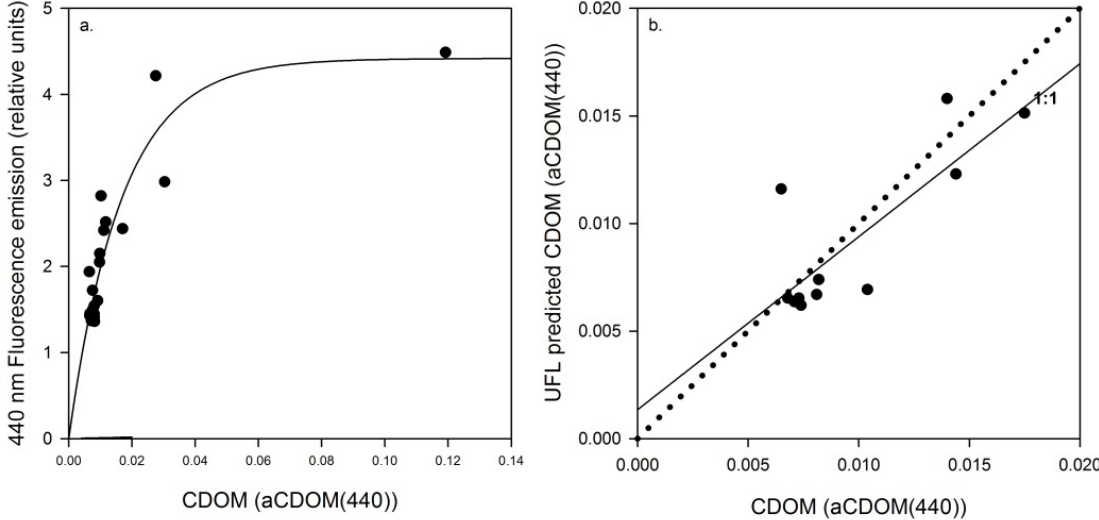
Figure 8. Field campaign specific ( a ) calibration (CDOM = 4.42 × (1 − exp ( − 59.49 × ); R = 0.92; p < 0.001) and ( b ) validation of UFL CDOM measurements (R = 0.82; UFL 440 p < 0.003; RMSE = 0.0022 a440 nm·m -1 ). Solid line is regression trend line; dotted line is